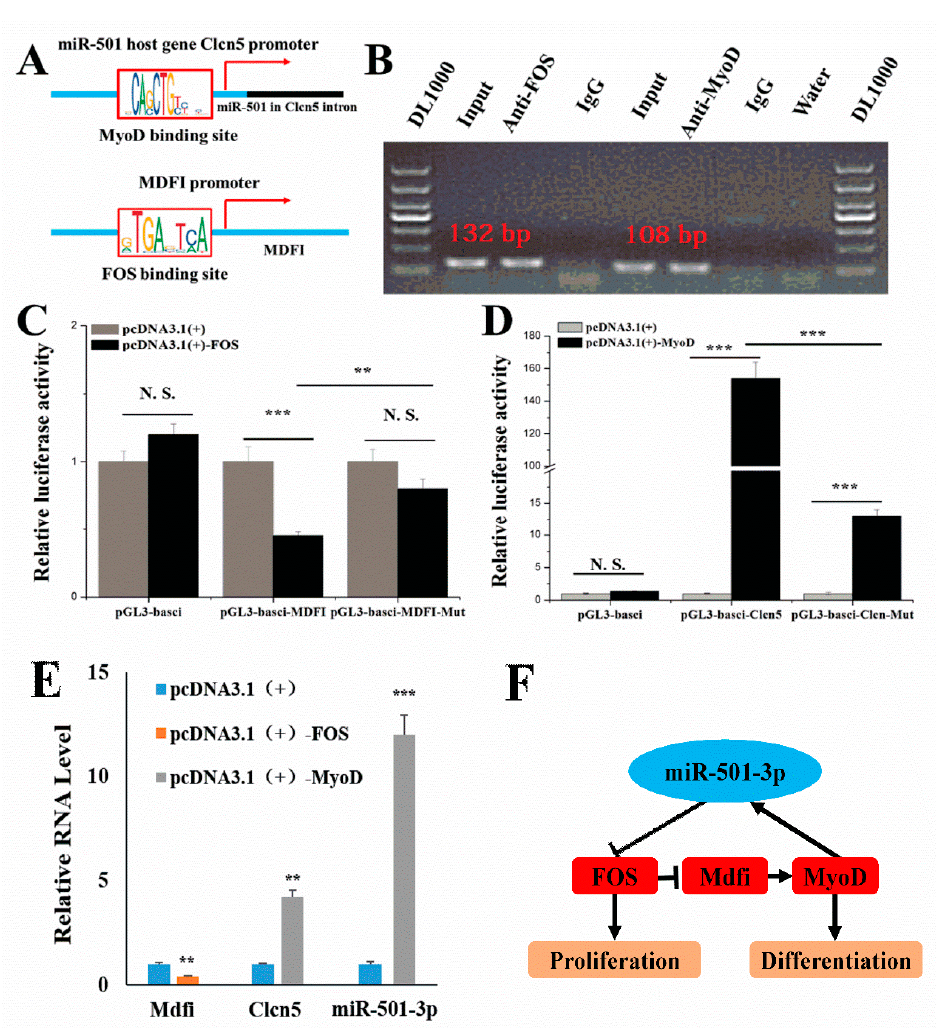
Figure 8. miR-501-3p formed a feedback loop with FOS, MDFI, and MyoD . ( A ) Schematic representation of MyoD binds at the upstream of miR-501-3p in the genome, and FOS binds at the upstream of MDFI in the genome. ( B ) ChIP experiments were used to verify that FOS and MyoD bound to the promoter regions of MDFI and Clcn5, respectively. ( C ) Luciferase reporters show FOS bound to the MDFI promoter region. ( D ) Luciferase reporters show MyoD bound to the Clcn5 promoter region. ( E ) QPCR results indicate that FOS inhibited the expression of MDFI and MyoD increased the expression of Clcn5 and miR-501-3p. ( F ) A feedback loop formed by miR-501-3p, FOS, MDFI, and MyoD to regulate myogenic di ff erentiation. **, p < 0.01; ***, p < 0.001. The results are presented as mean ± S.E.M. of three replicates for each